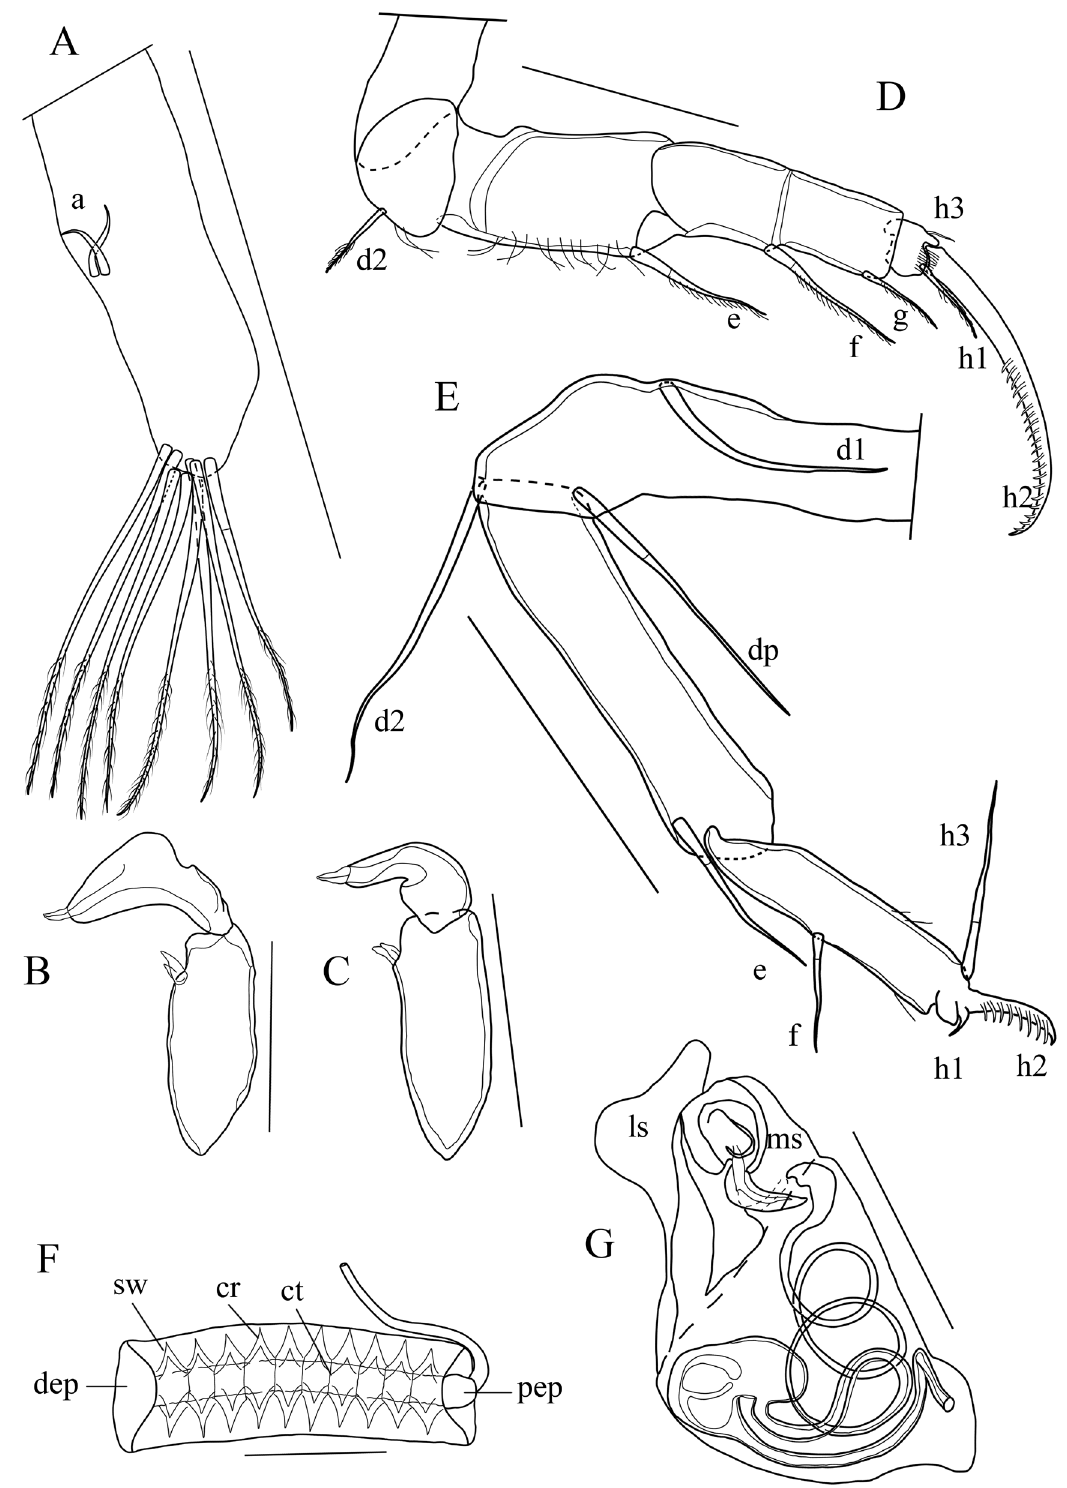
Fig. 6. Brasilodopsis baiabonita gen. et sp. nov. from Bonito, State of Mato Grosso do Sul, ♂. A . T1 (MZUSP 41825). B . Rpp (MZUSP 41827). C . Lpp (MZUSP 41827). D . T2 (MZUSP 41825). E . T3 (MZUSP 41827). F . Zenker’s organ (MZUSP 41827). G . Hemipenis (MZUSP 41827). Abbreviations: see text and Material and methods. Scale bars: 50